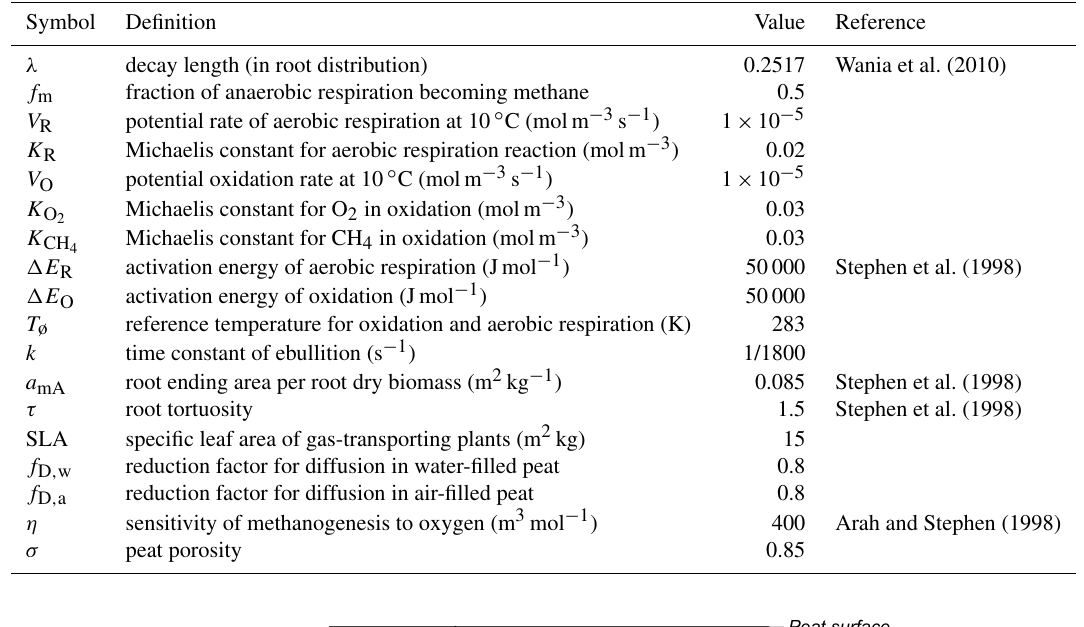
Table 1. Model parameters and their values. The reference is given in the cases where the value is directly from one study; otherwise, the parameter value is discussed in Sect. 3.2.